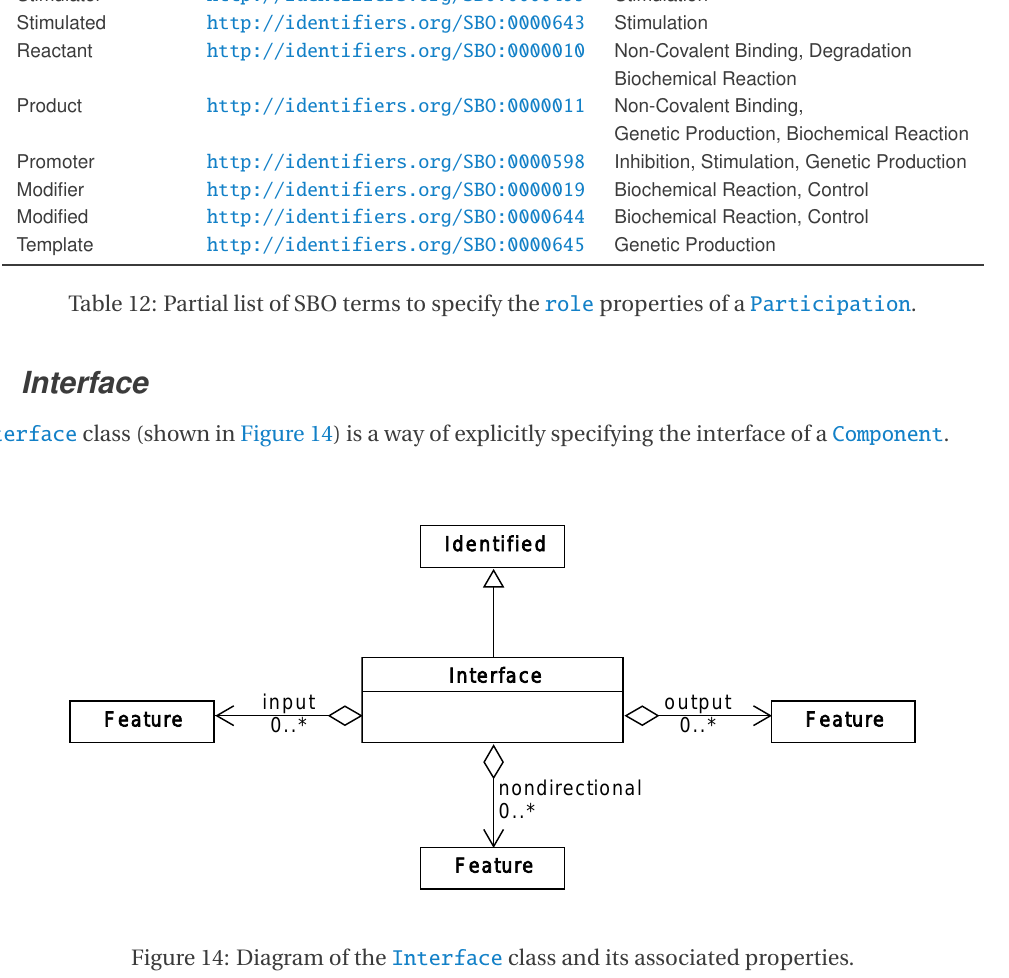
Figure 14: Diagram of the Interface class and its associated